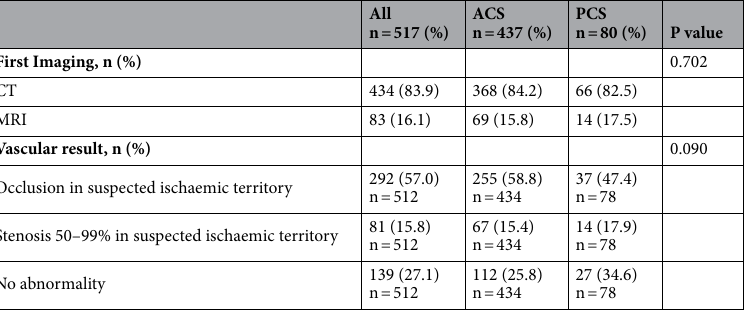
Table 4. Patient characteristics—imaging. Imaging characteristics of all 517 patients and patient groups according to stroke territory, ACS and PCS. Data are expressed as number of patients (n) and percentages. CT indicates computer tomography; MRI, magnetic resonance imaging; PWI, perfusion weighted imaging. P values were obtained according to Pearson’s Chi-squared test and Fisher’s Exact test, where appropriate. P values < 0.05 are shown in bold.